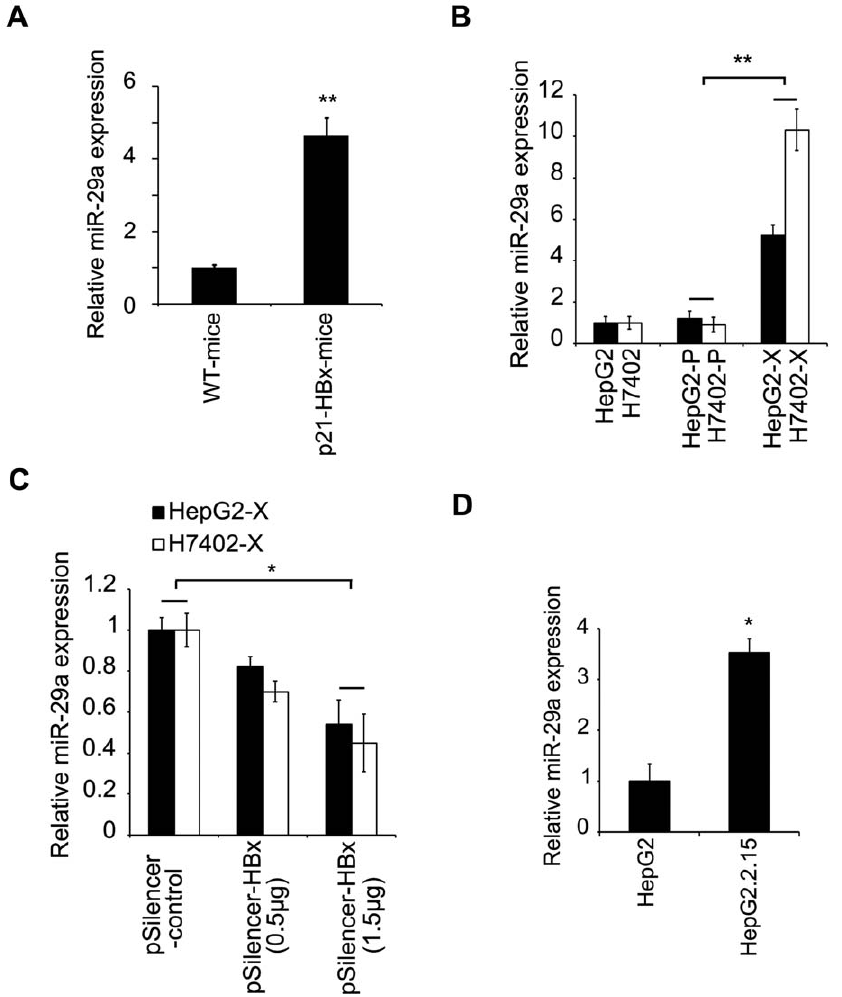
Figure 1. HBx upregulates miR-29a. (A) The relative expression of miR-29a for 6-month-old p21-HBx transgenic mice versus WT mice was detected by qRT-PCR. (B) The expression of miR-29a in stable HBx-transfected hepatoma cell lines was examined by qRT-PCR. (C) The expression levels of miR-29a in HepG2-X (or H7402-X) were examined by qRT-PCR after treatment with HBx RNAi in a dose dependent manner. (D) The relative expression level of miR-29a in HepG2.2.15 cells was examined by qRT-PCR. Plotted are the means 6 SD of three samples normalized to U6. Statistically significant differences, arbitrarily set to 1.0, are indicated: *P , .05, **P , .01, Student’s t test.